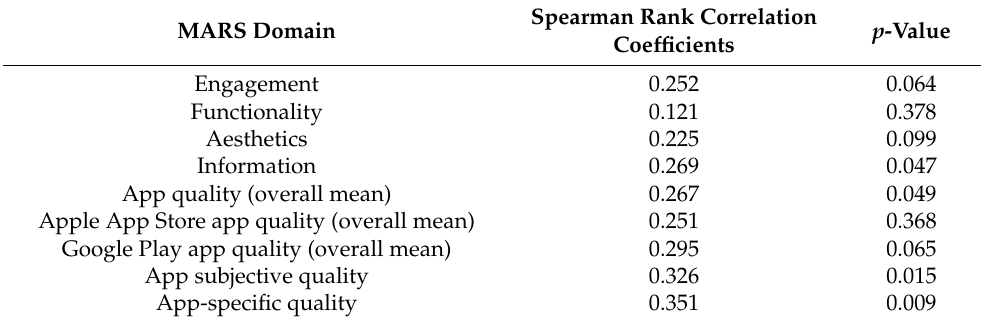
Table 3. Correlations between MARS scores and number of behaviour change techniques in the analysed apps.